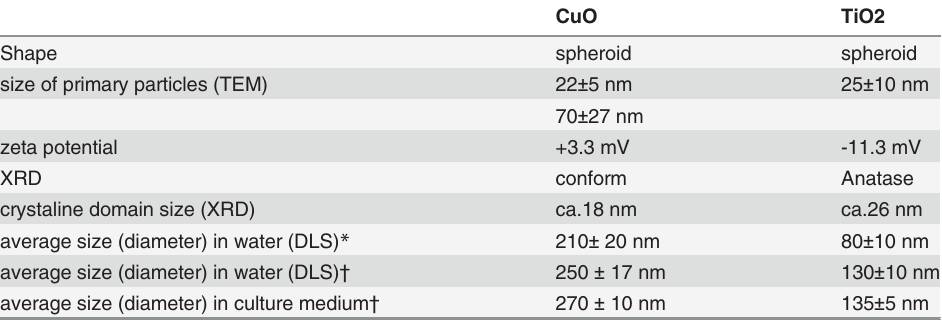
Table 1. Characterization of the two nanoparticles used in this study. CuO TiO2 Shape spheroid spheroid size of primary particles (TEM) 22 ± 5 nm 25 ± 10 nm 70 ± 27 nm zeta potential +3.3 mV -11.3 mV XRD conform Anatase crystaline domain size (XRD) ca.18 nm ca.26 nm average size (diameter) in water (DLS) * 210 ± 20 nm 80 ± 10 nm average size (diameter) in water (DLS) † 250 ± 17 nm 130 ± 10 nm average size (diameter) in culture medium † 270 ± 10 nm 135 ± 5